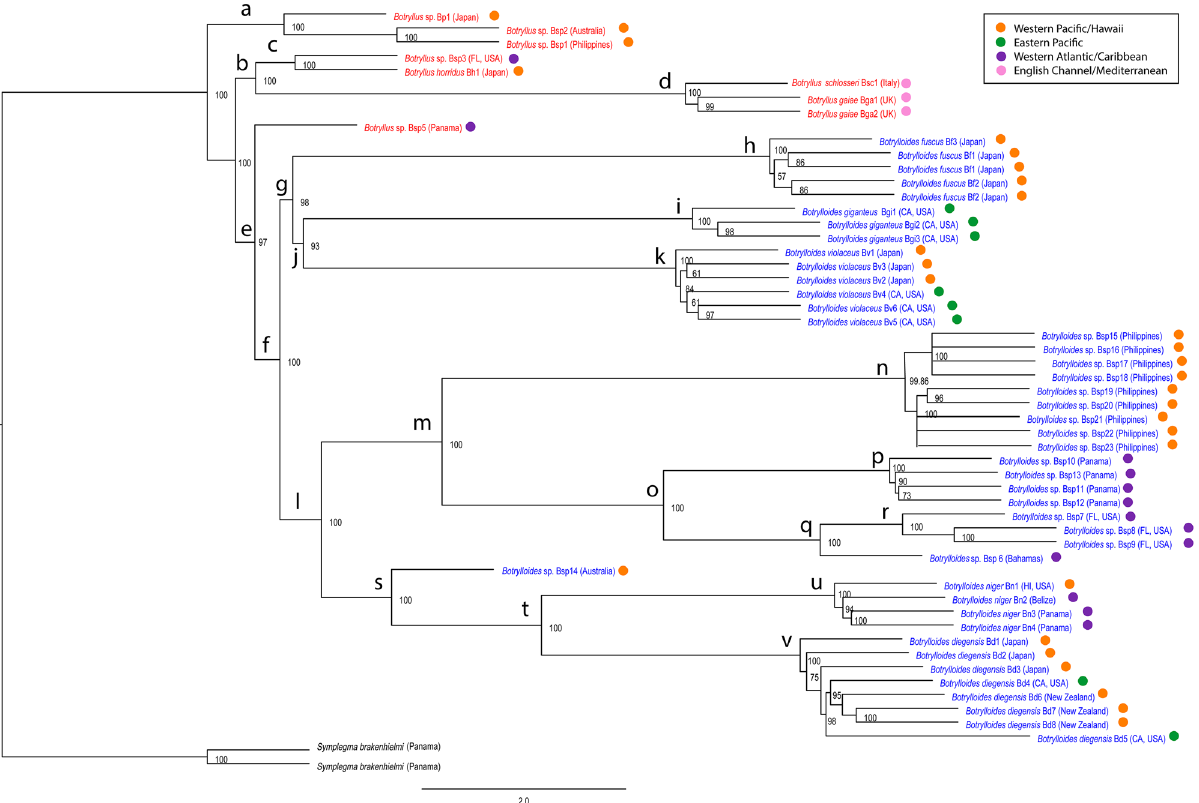
Figure 1. Maximum Quartet Support Species Tree of relationships among botryllid species, using the program Accurate Species TRee ALgorithm (ASTRAL). Nodes with less than 50% posterior probability support have been collapsed. The scale bar indicates two coalescent units. Red text = Genus Botryllus, Blue text = Genus Botrylloides. Colored circles refer to geographic regions (Orange = Western Pacific/Hawaii, Green = Eastern Pacific, Purple = Western Atlantic/Caribbean, Pink = English